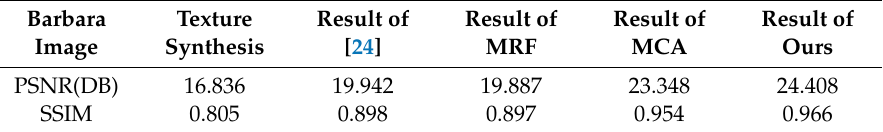
Table 1. Comparisons of Statistical Indices on Barbara Image.